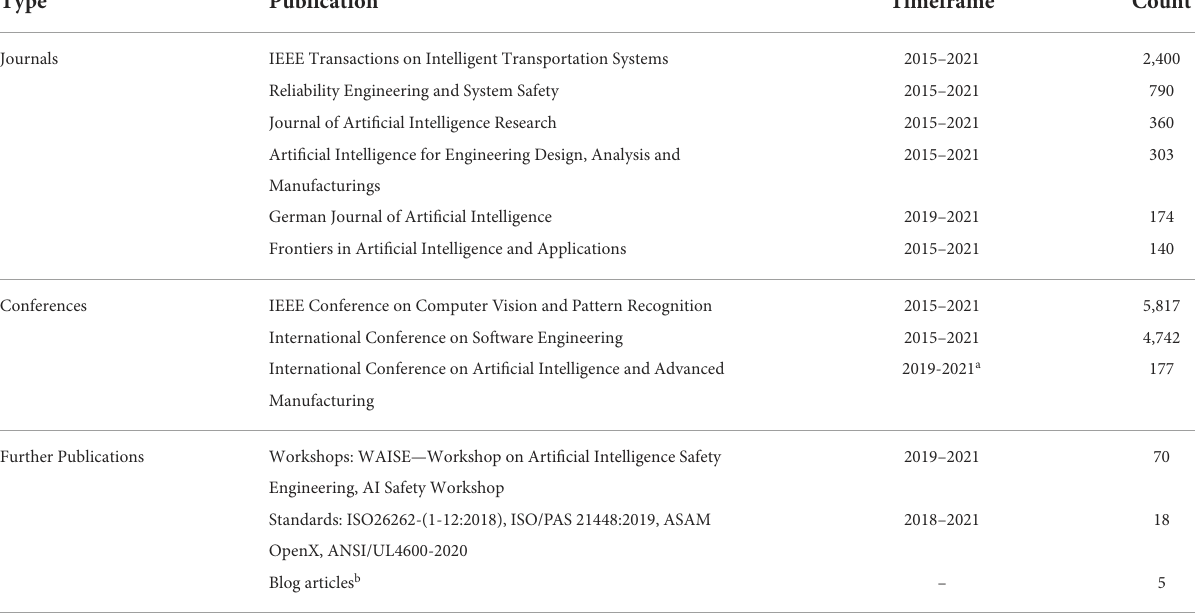
TABLE 3 Overview of the database sorted by number of